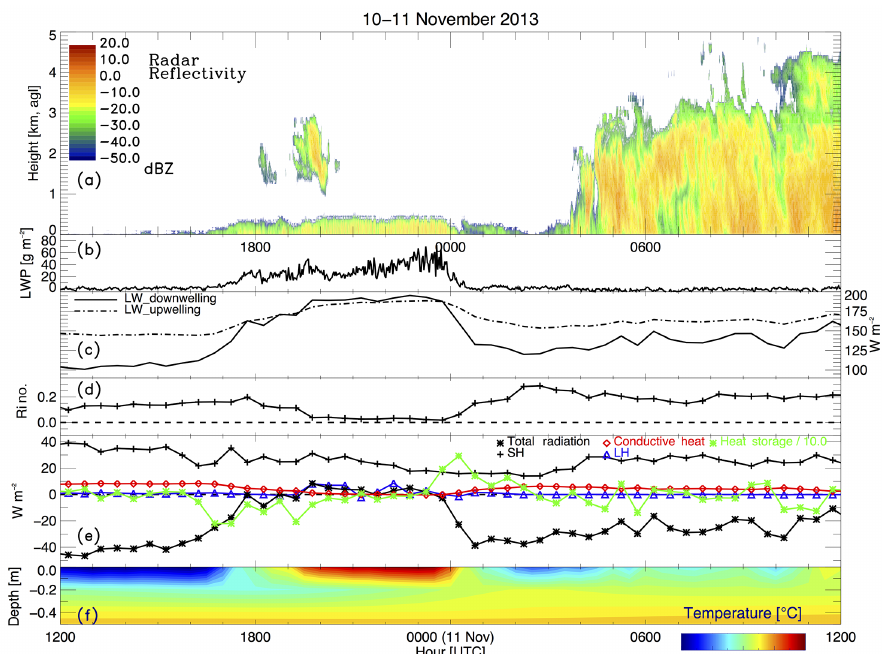
Figure 5. A case study from 12UTC on 10 November 2013 to 12UTC on 11 November 2013. (a) Cloud occurrence as seen by the MMCR; (b) liquid water path; (c) longwave upwelling and downwelling radiation; (d) Richardson number; (e) surface energy fluxes: total radiation, sensible heat, latent heat, conductive heat, and heat storage/10.0; and (f) subsurface